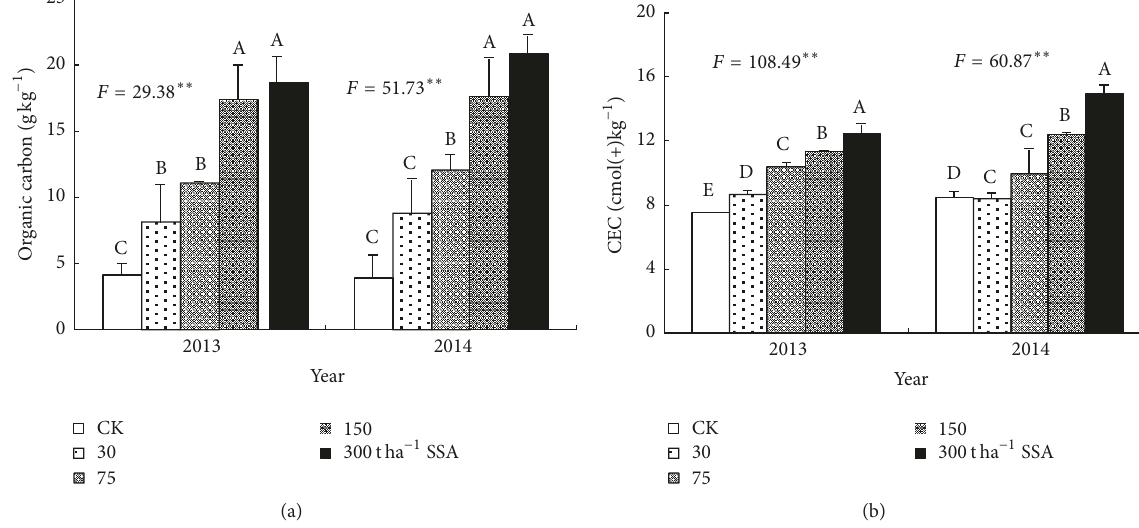
Figure 3: Effects of sewage sludge amendment (SSA) combined with green manuring on organic carbon (a) and CEC (b) of coastal mudflat salt-soil. Vertical bars indicate standard deviations of the means. Columns with different letters show significant difference between sewage sludge amendment rates at 𝑝 < 0.05 by LSD’s multiple range test. Values of 𝐹 are the 𝐹 test in ANOVA; ∗∗ 𝑝 < 0.01 . CEC, cation exchange